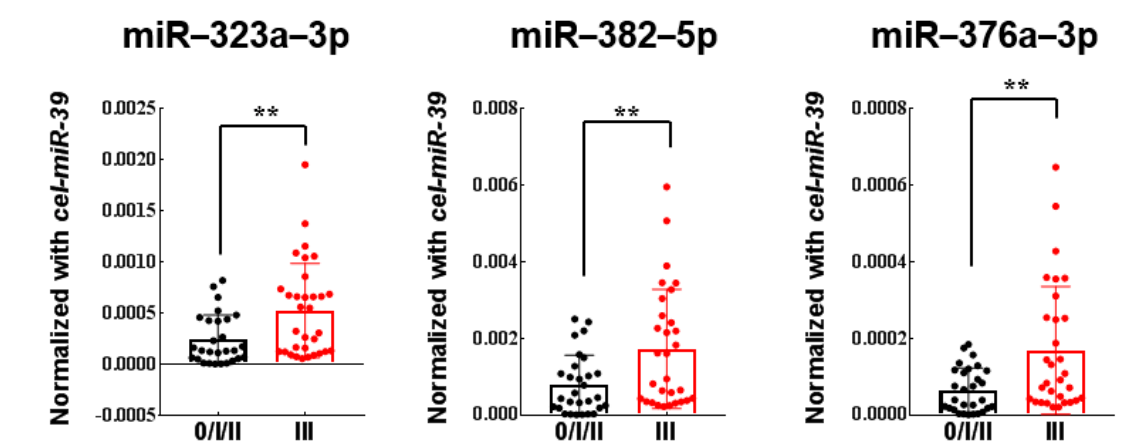
Figure 2. Analysis of 79 plasma samples by qRT-PCR (validation cohort, stage 0/I/IIA vs. IIIB/IIIC). Higher expression of three miRNAs (miR-323a-3p, miR-382-5p, miR-376a-3p) was significantly associated with lymph node metastasis. miR-323a-3p (** p = 0.0049), miR-382-5p (** p = 0.0053), miR-376a-3p (** p = 0.0024).